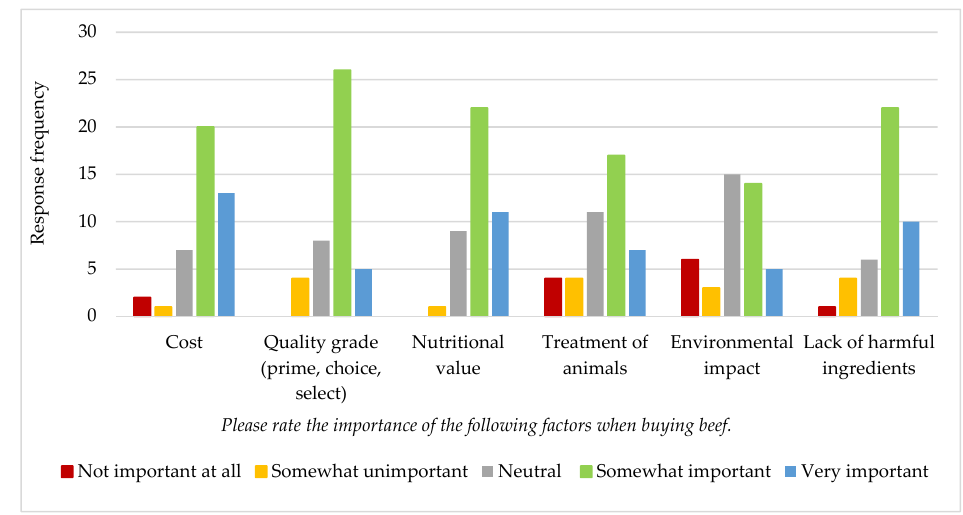
Figure 4. Importance of various factors to Idaho parents when buying beef ( n = 43). Table 3. Estimated dietary intakes of and recommended intakes for beef, protein, iron, zinc, and choline at 6–12 months of